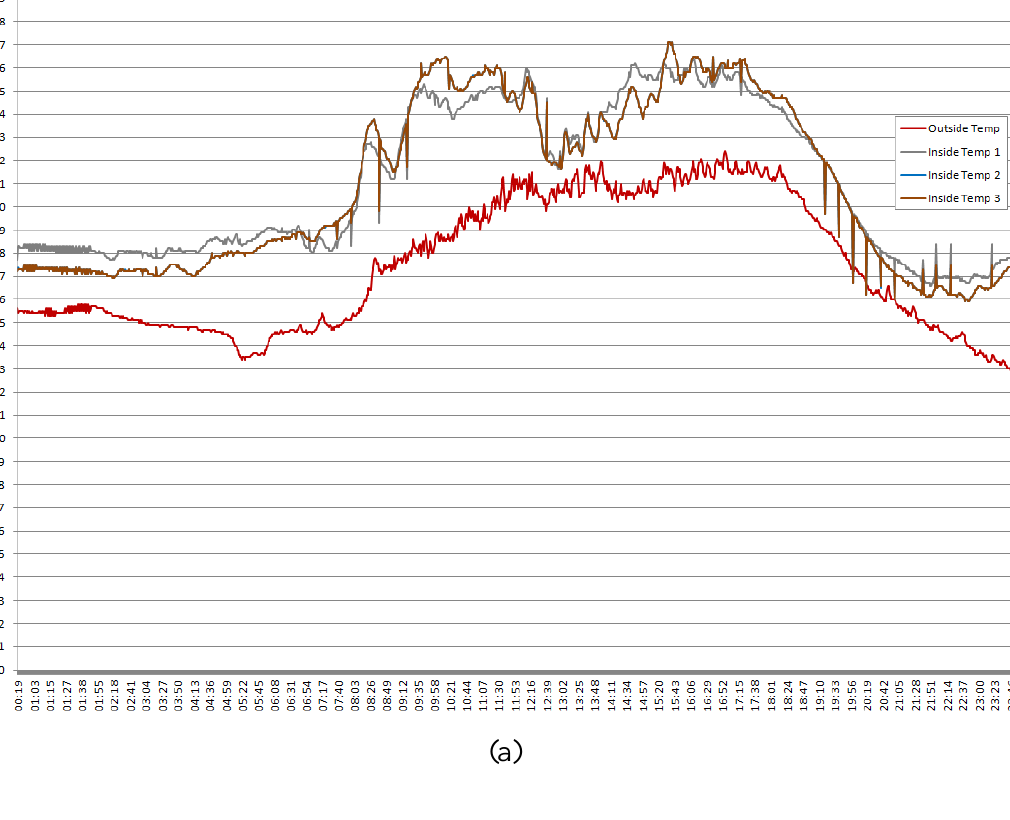
Figure 15. Measured Environmental Data Graph (1 June 2010). (a) Inside Temperature and Outside Temperature; (b) Inside Humidity; (c) CO